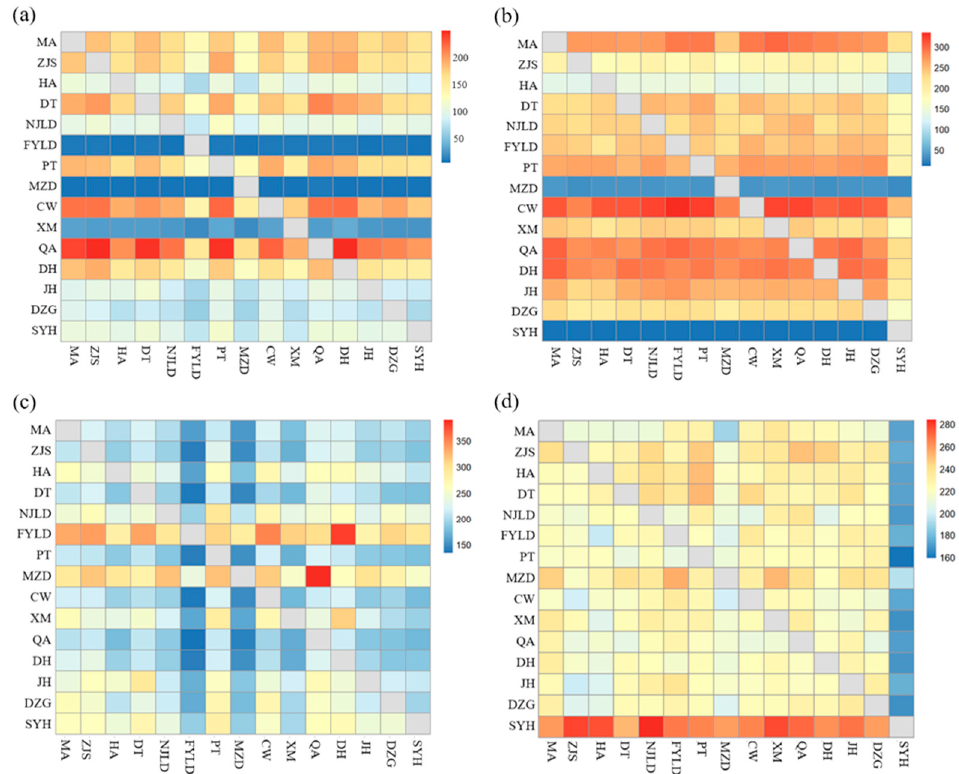
Figure 3. Historical gene flow (Nm) and migration rate (M) among 15 populations of horn-eyed ghost crab based on COI and D-Loop sequences. ( a ) Nm values based on COI sequences; ( b ) Nm values based on D-Loop sequences; ( c ) M values based on COI sequences; ( d ) M values based on D-Loop sequences.